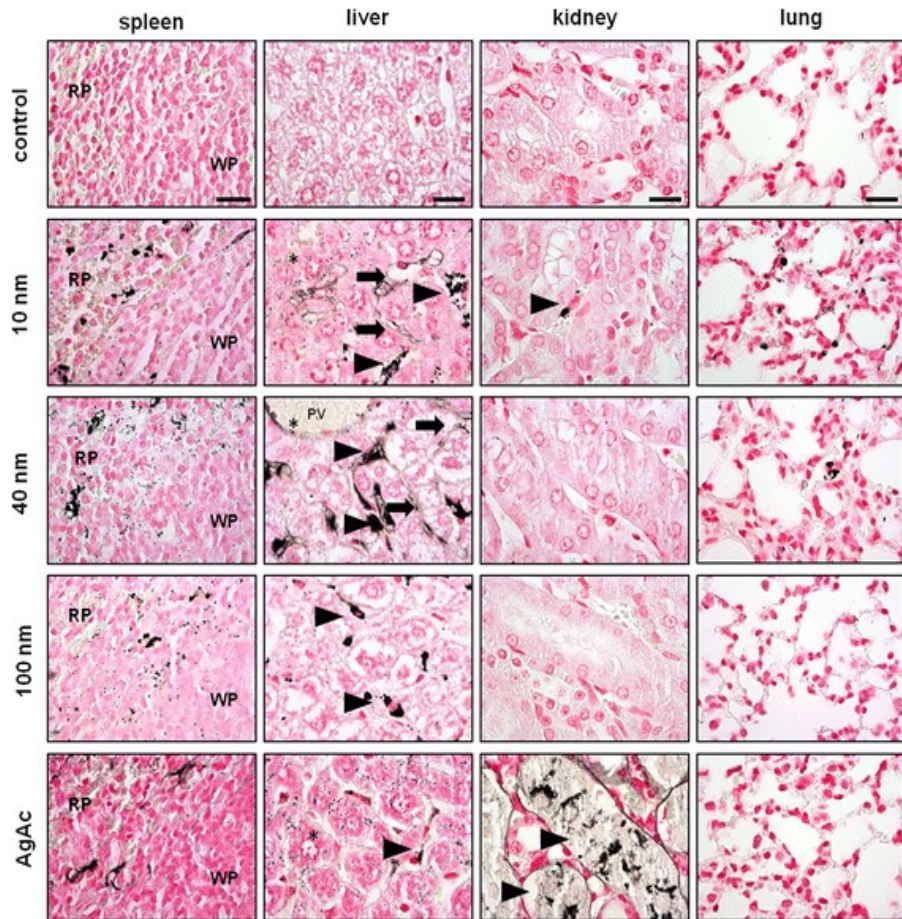
Figure 26. Histological examination of silver tissue localization by autometallography staining. Representative images of spleen, liver, kidney, and lung (scale bar = 20 μm), from AgNPs (10, 40, 100 nm) and silver acetate treated mice. In the spleen, silver was localized within the cytoplasm of macrophages especially in the spleen white pulp (WP) and red pulp (RP). Triangles indicate the accumulation of silver in organ tissues. Reproduced from [229], BioMed Central Ltd under the Creative Commons Attribution License.